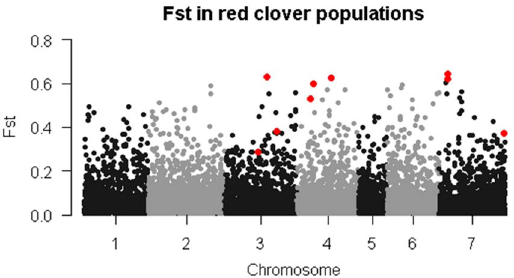
Figure 4. Manhattan plot of average F ST values over the four subpopulations identified in the UPGMA analysis. The markers highlighted in green represent markers with high F ST values and/or of interest because of their putative function. These markers are also highlighted in Supplementary Table S4.